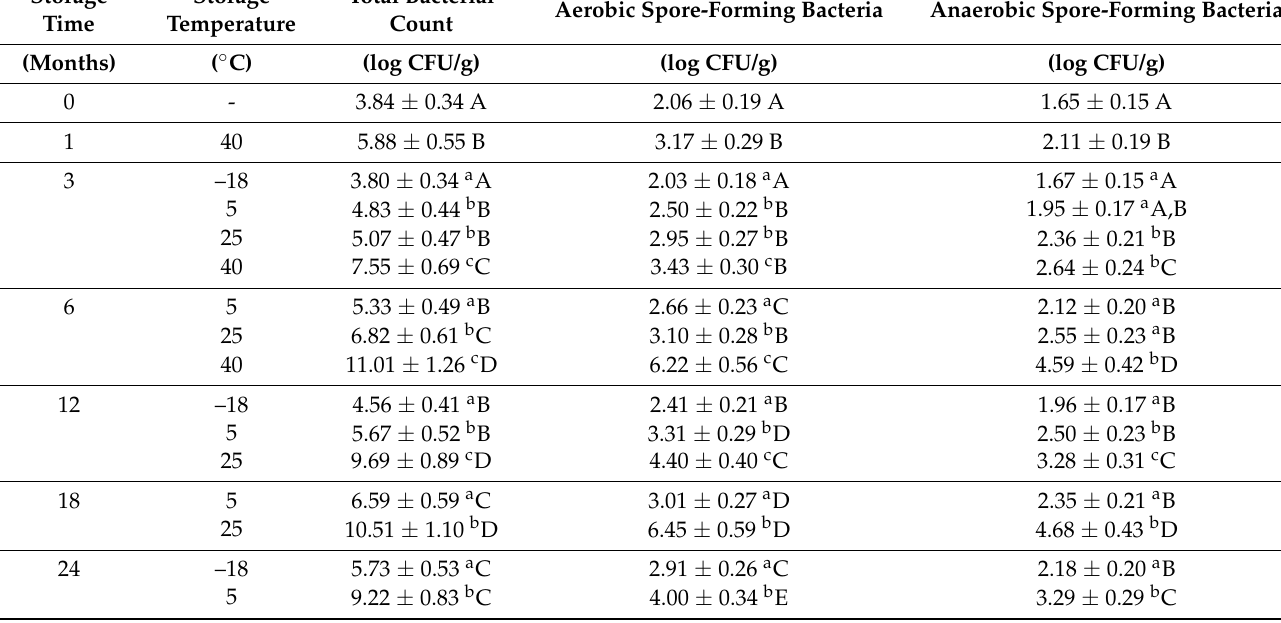
Table 1. Result of the microbiological analysis of instant goulash soup during a 24-month period at four different temperatures ( − 18 ◦ C; 5 ◦ C; 25 ◦ C and 40 ◦ C). The results are expressed as means ± standard deviation ( n = 27)